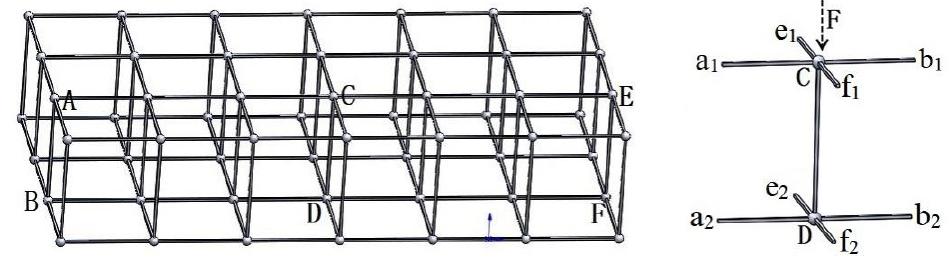
Figure 5. Three-dimensional truss structure and force diagram of its web member.